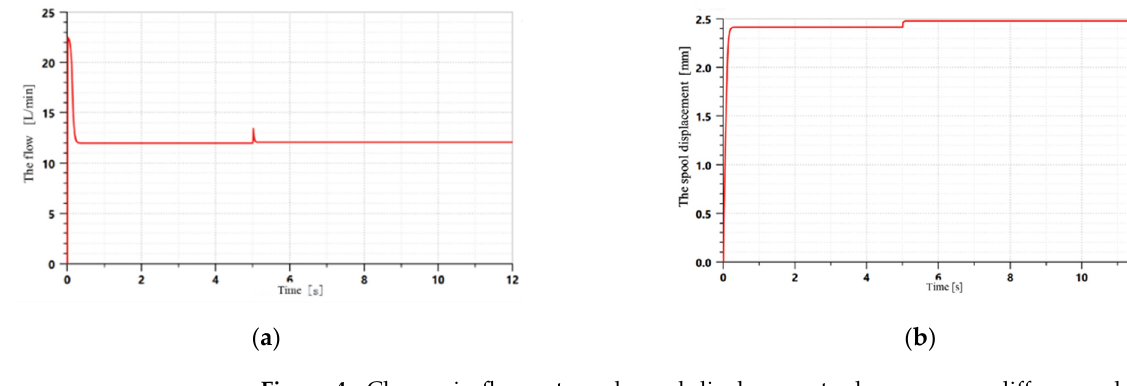
Figure 4. Change in flow rate and spool displacement when pressure difference changes from 2 MPa to 4 MPa. ( a ) Change in pressure difference of flow rate; ( b ) Change in pressure difference of spool displacement.